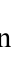
Figure 6. Structure of N -alkylated chitosan derivatives.